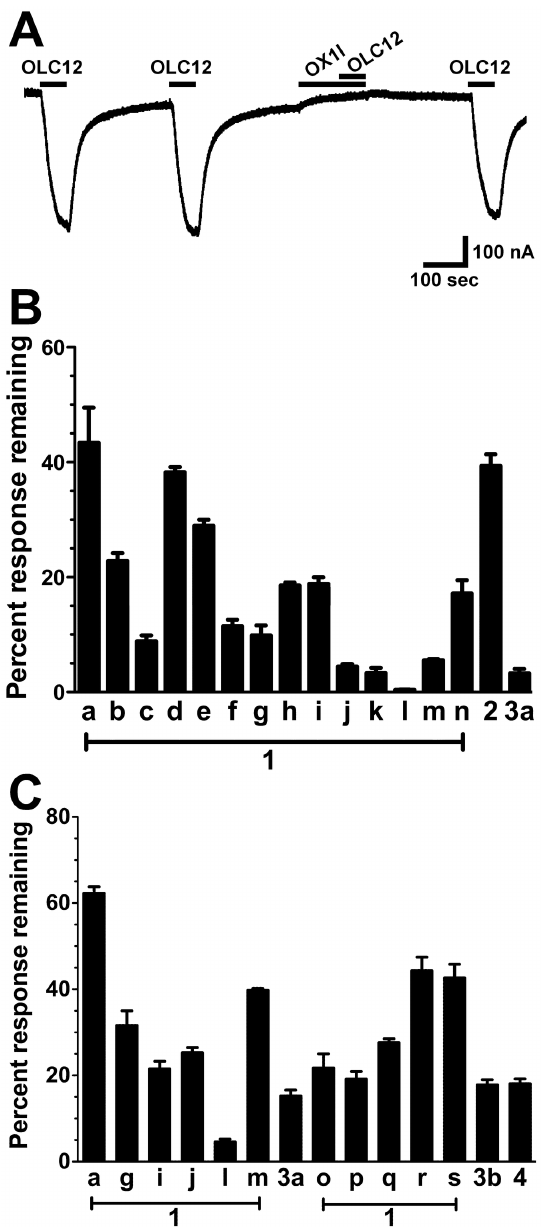
Figure 3. A screen of OX1a analogs for Orco antagonist activity. A . An example of the antagonist screening protocol. An oocyte expressing Cqui\Orco+Cqui\Or21 was exposed to 60 sec applications of 3 µM OLC12 with 4 min washed between applications. 100 µM OX1l was applied for 90 sec preceding the third application of OLC12 and then co-applied during the OLC12 application. B . Responses of Cqui\Orco+Cqui\Or21 to 3 µM OLC12 (~EC ) in the presence of 100 µM of each analog are 25 presented as a percentage of the average of the two preceding responses to OLC12 alone (mean ± SEM, n = 3-7). Inhibition by OX1d and OX2 did not differ from inhibition by OX1a. Inhibition by all other compounds was significantly different from inhibition by OX1a: OX1e (p<0.05); OX1b-c,f-n, OX3a (p<0.001). C . A screen of additional OX1a analogs for Orco antagonist activity. Responses of Cqui\Orco+Cqui\Or21 to 3 µM OLC12 in the presence of 30 µM of each candidate antagonist are presented as a percentage of the average of two preceding responses to OLC12 alone (mean ± SEM, n=3-5). Inhibition by all compounds was significantly different from inhibition by OX1a (p<0.001). Inhibition by OX1i was significantly different (p<0.001) from values for OX1r and OX1s. Inhibition by OX1l was significantly different from values for OX1o (p<0.001) and OX1p (p<0.05). Inhibition by OX1m was significantly different (p<0.001) from values for OX1o and OX1p. Inhibition values that did not differ are: OX1g and OX1q, OX1j and OX4, OX1m and OX1q. doi: 10.1371/journal.pone.0084575.g003 PLOS ONE |